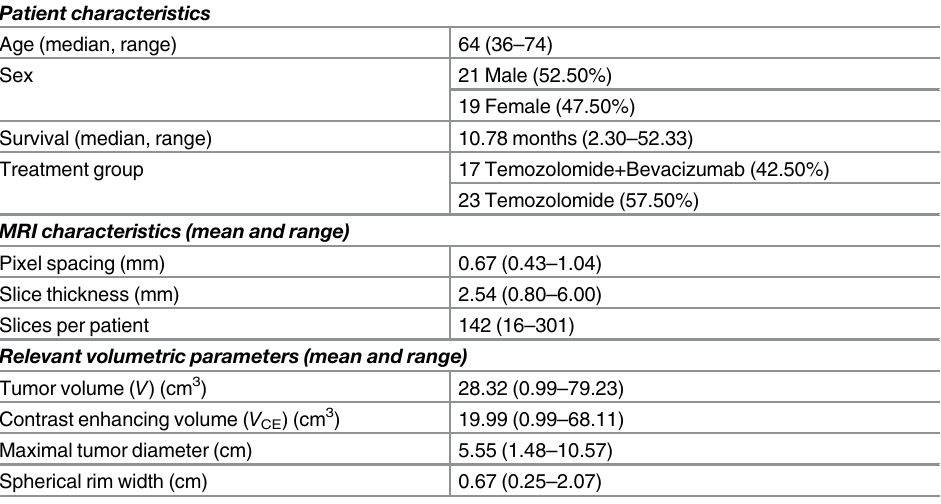
Table 1. Summary of patient characteristics, MRI data and volumetric parameters for the 40 patients included in the study.